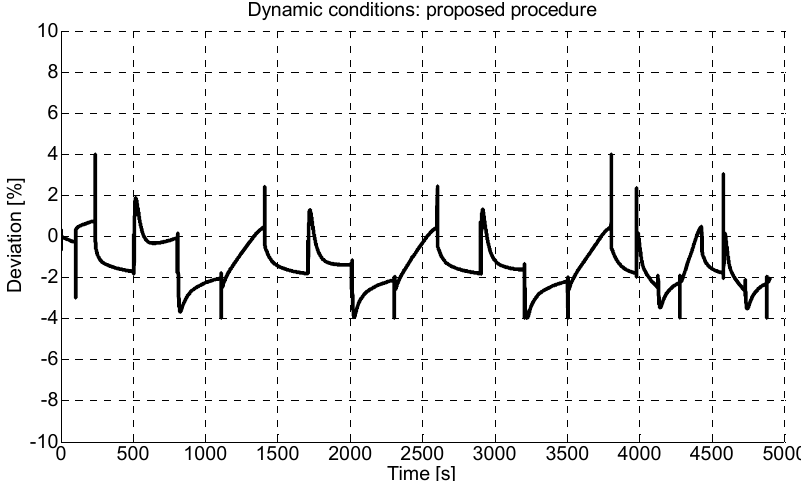
Figure 12. Test in dynamic conditions: relative deviation among measured data and model output (proposed